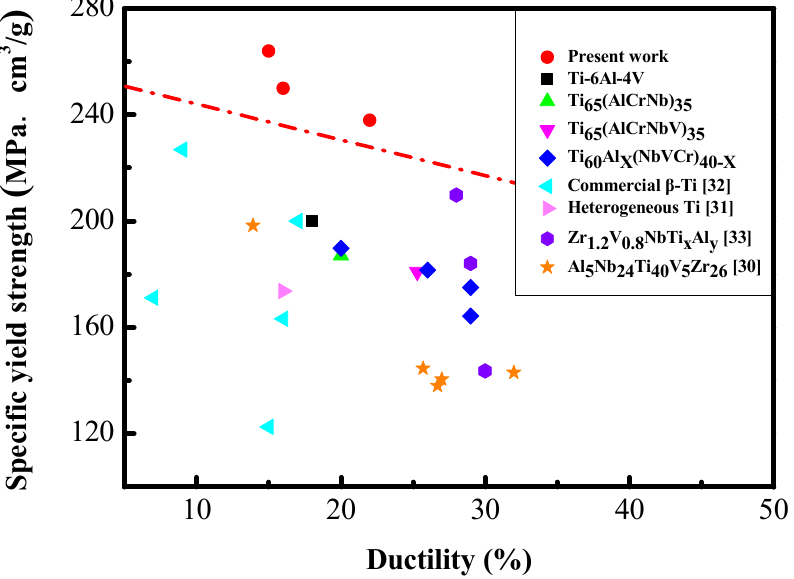
Figure 8. Comparison of specific yield strength and ductility [30–33]. Dashed line separates the data of the present work and previous reports.